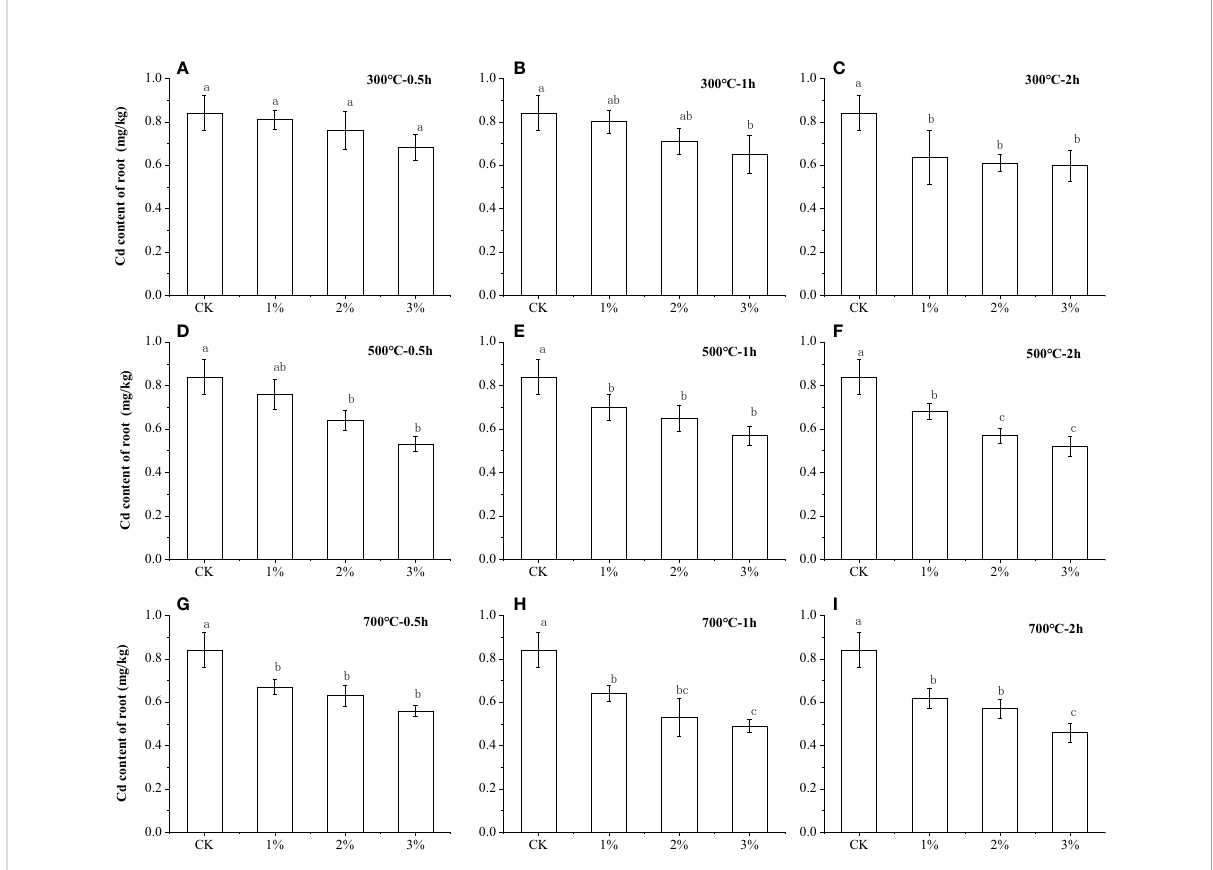
FIGURE 2 Comparison of the Cd content of lettuce root after water hyacinth biochar application with different preparation conditions. Small letters indicates signi fi cant